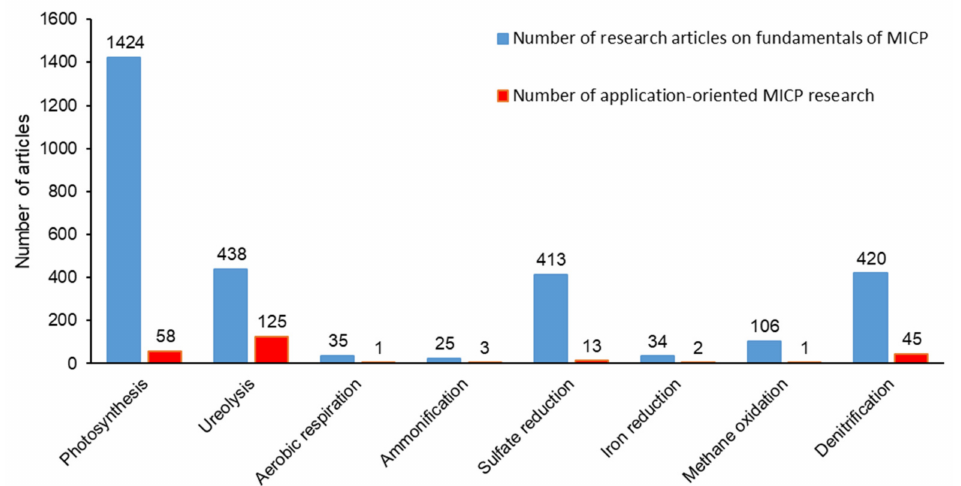
Figure 1. Number of research papers conducted on MICP through different microbial metabolic pathways based on the database of Web of Science from 2000 to 2021. The first column represents the search on the topic of “calcium carbonate” OR “calcite precipitation” OR “carbonate precipita- tion”, and the keyword of photosynth*, ureoly*, “aerobic respiration,”, ammonification, “sulfate reduction,” “iron reduction,” “methane oxidation,” and “denitrification”, respectively. The second column represents the number of articles searched on two additional keywords “technology” OR